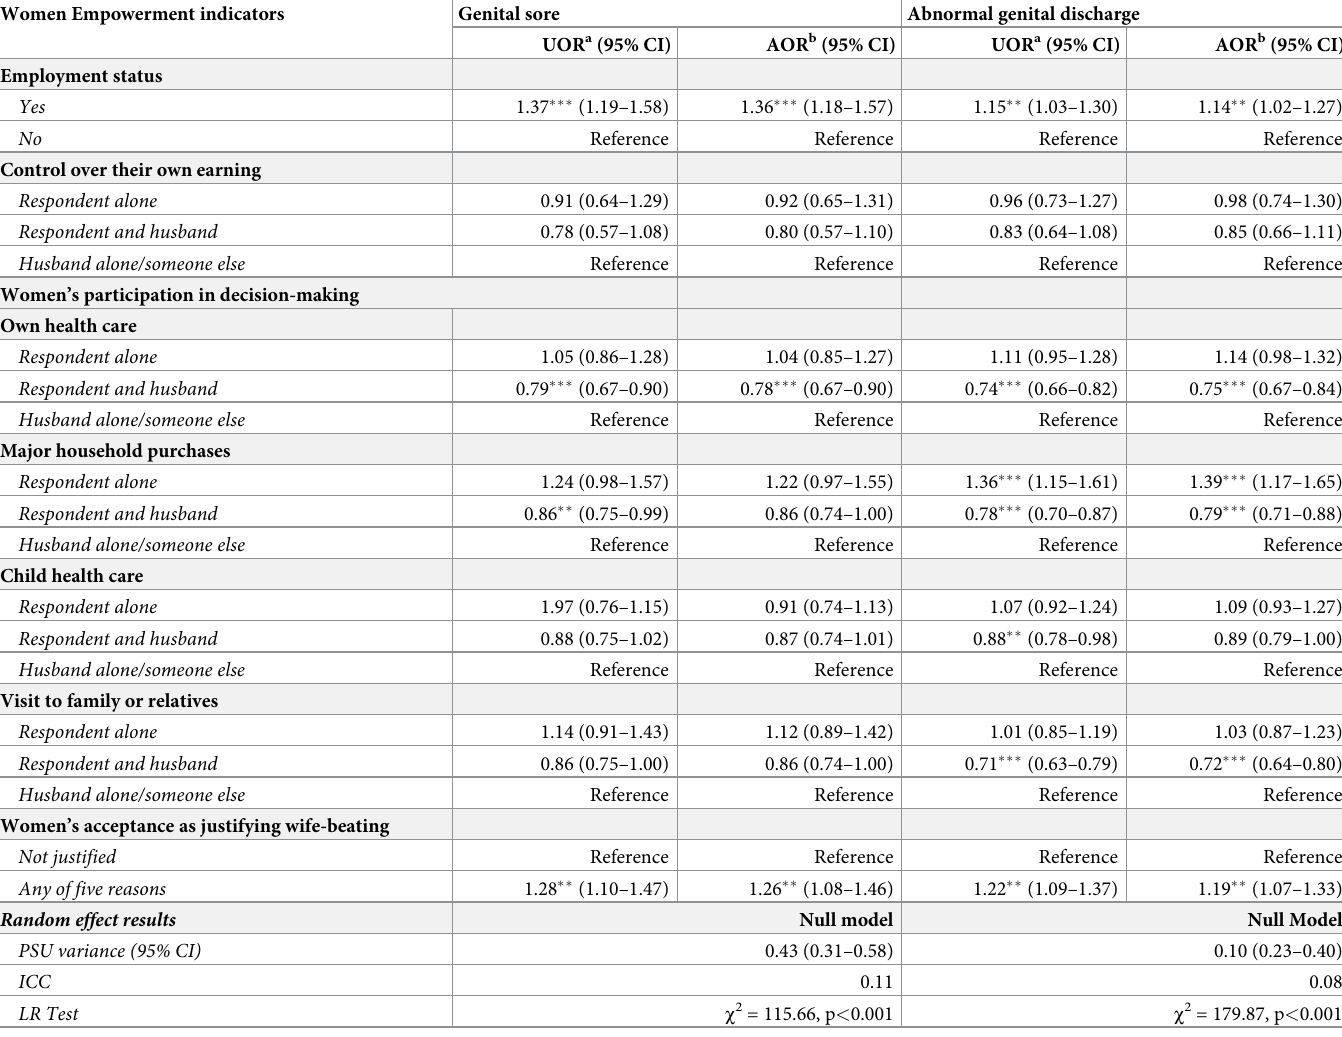
Table 4. Bivariable and multivariable multilevel mixed-effect logistic regression analysis to explore the association between women empowerment indicators and women’s self-reported experience of genital sore and genital discharge in the past 12 months of the survey, 2014